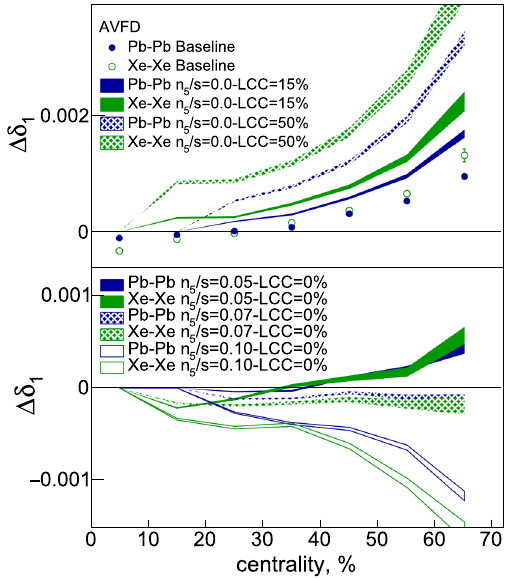
Fig. 5 The centrality dependence of (cid:9)δ 1 grouped in two scenarios: √ zero n 5 / s but various choices of LCC (upper panel) and non-zero n 5 / s s NN = but LCC fixed to zero (lower panel). The various bands show the AVFD expectations for (cid:9)δ 1 for Pb–Pb collisions and Xe–Xe collisions, with blue and green bands, respectively. The results of the baseline sample are represented by the filled and open markers